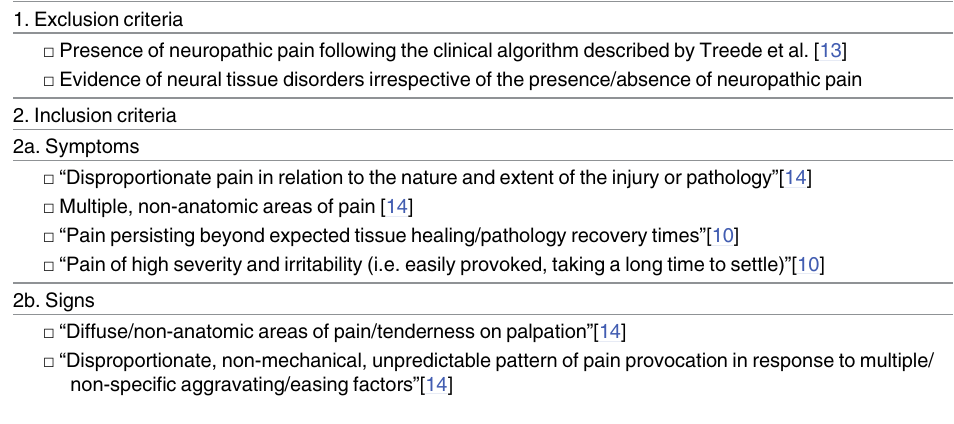
Table 1. Exclusion and inclusion criteria for